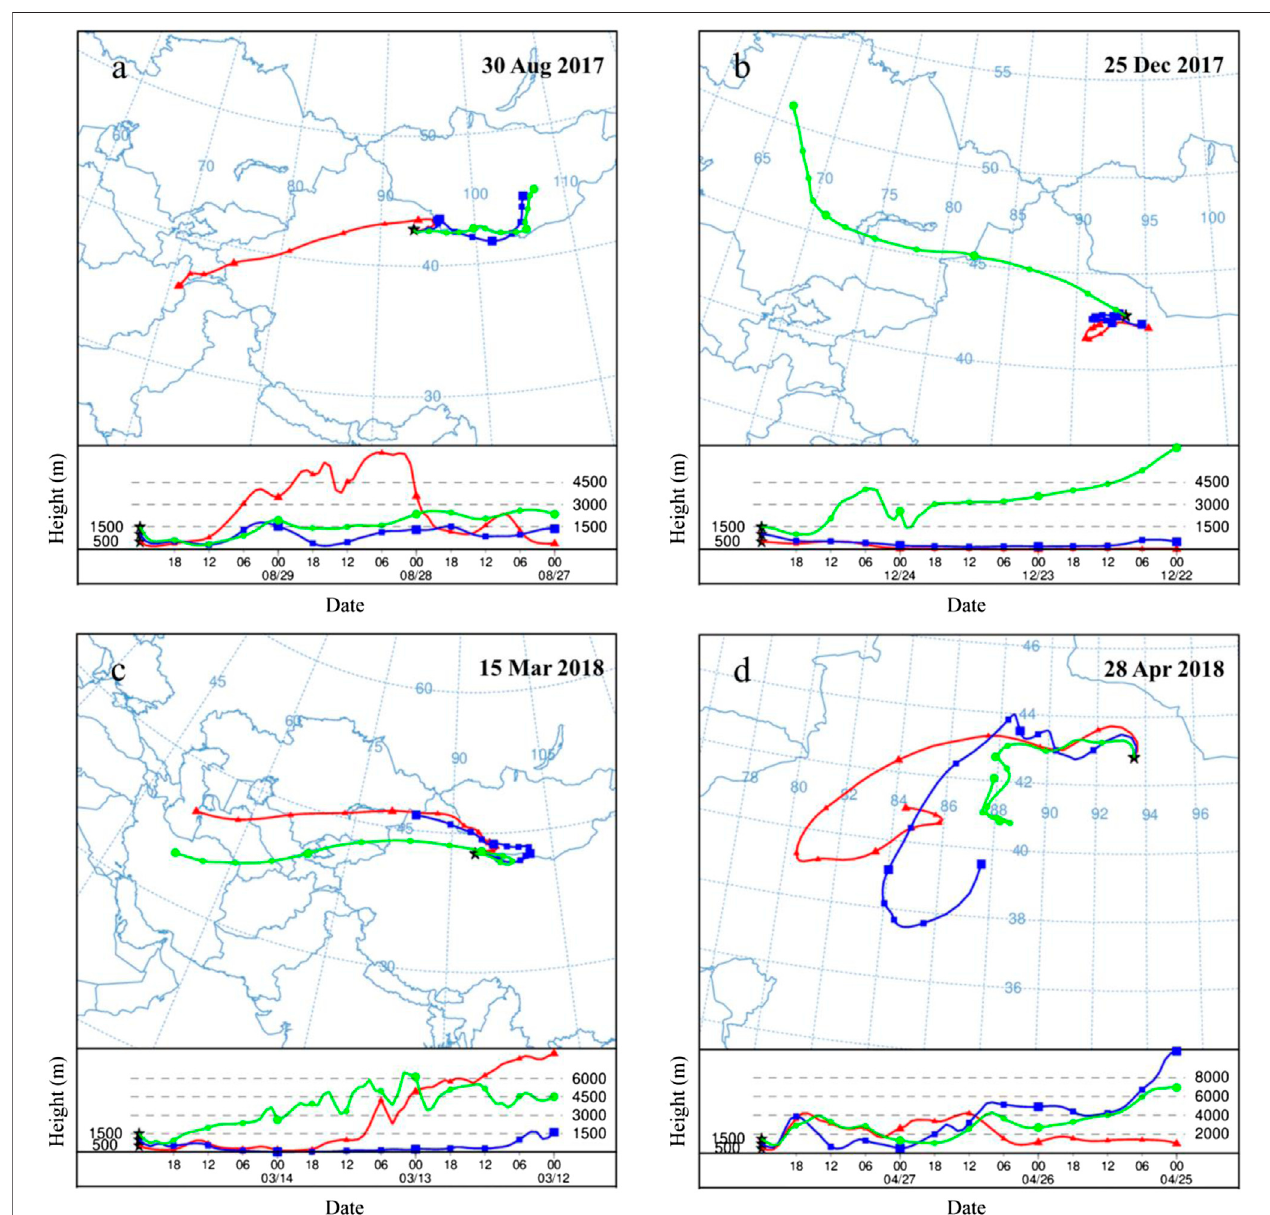
FIGURE 8 | Backward trajectory analysis of several large-scale sandstorm air masses that reached Yushugou Glacier No. 6 during the study period (2017 and 2018).